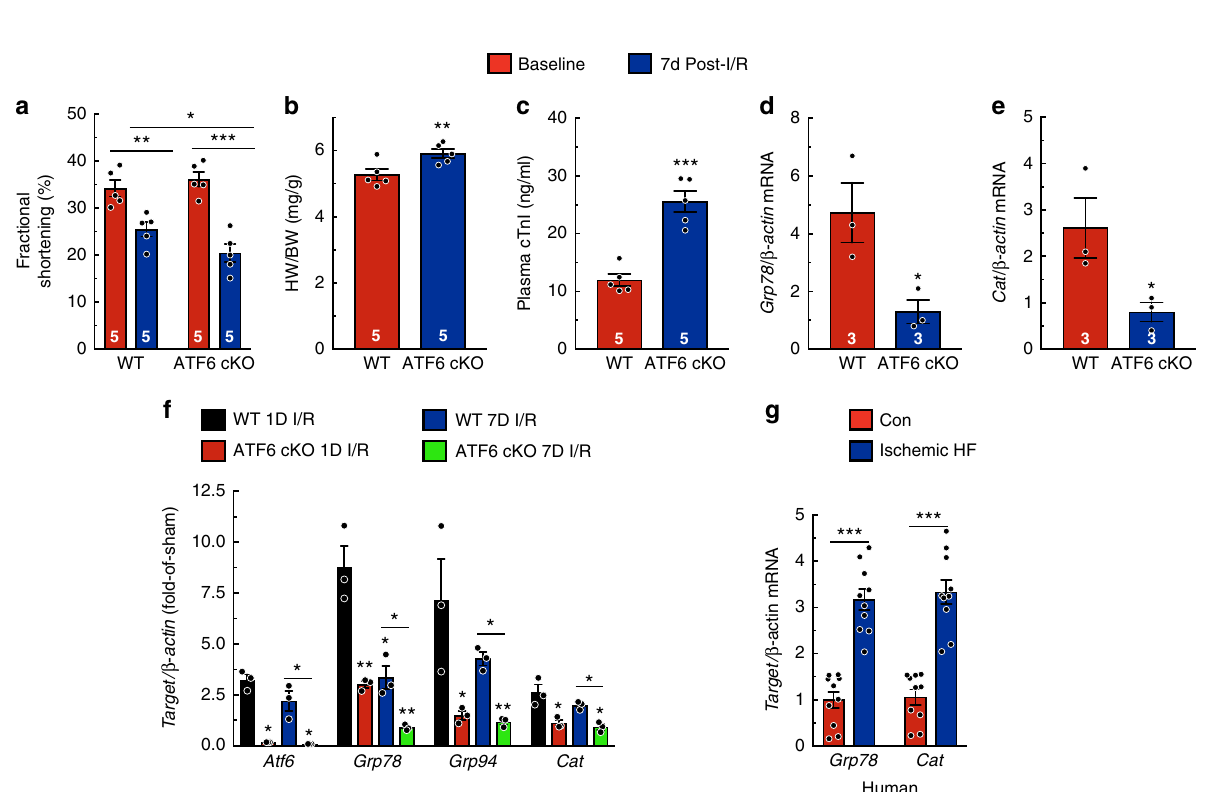
Fig. 2 Endogenous ATF6 is cardioprotective in a model of a chronic AMI. a – e Parameters from mice 7 days post I/R. a Fractional shortening. Detailed analyses of echocardiography parameters are in Extended Data Table 1 ( n = 5). b Ratio of heart weight to body weight. c Plasma cTnI. d , e qPCR for Grp78 ( d ) or Cat ( e ) in border zone of mice ( n = 3). f qPCR for Atf6 and ATF6 target genes Grp78 , Grp94 , and Cat in WT ( n = 3) and ATF6 cKO ( n = 3) mice either 1 day or 7 days after I/R. g Quantitative real-time PCR (qPCR) for Grp78 or Cat in ventricular explants from control ( n = 10) or ischemic heart failure ( n = 10) patients. Data are represented as mean ± s.e.m. Two-group comparisons were performed using Student ’ s two-tailed t test, and all multiple